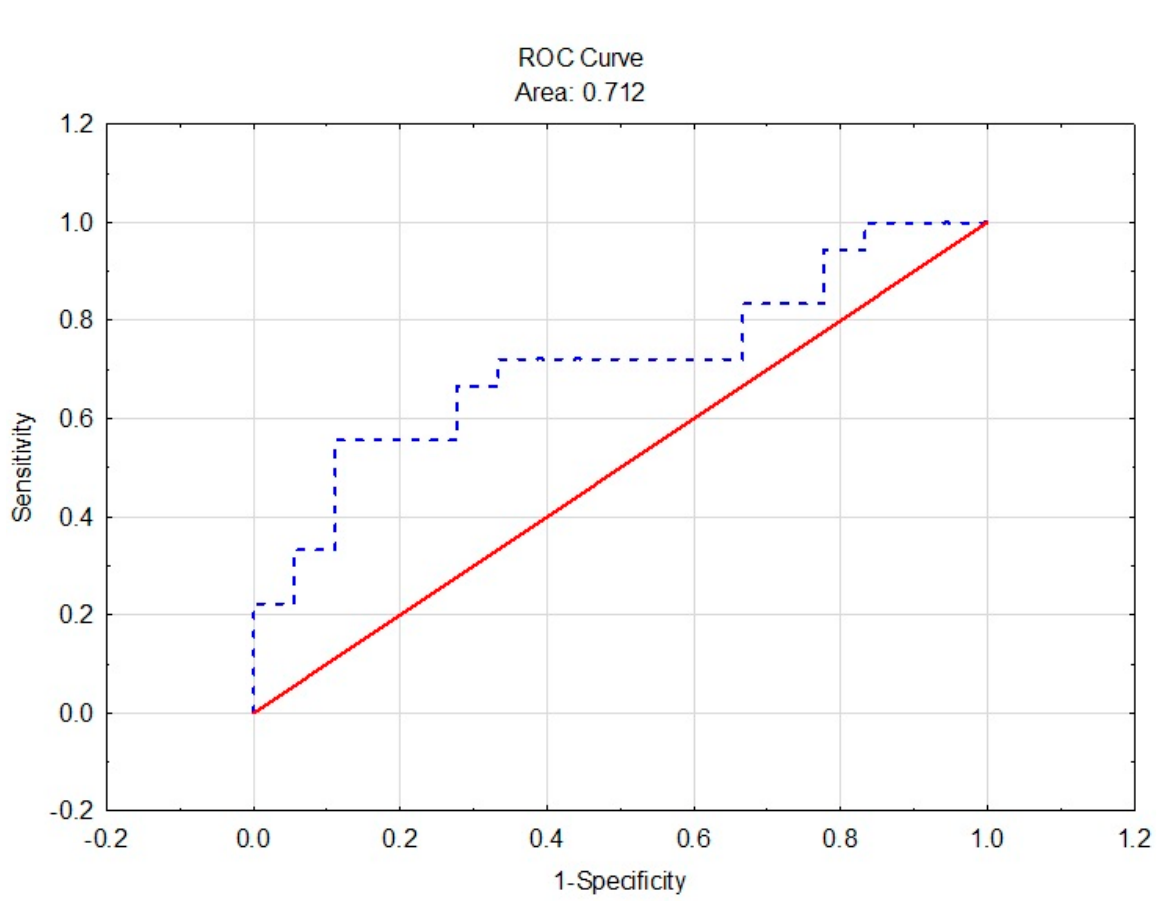
Figure 2. ROC curve of the bilateral extensor imbalance (% Ext). Table 6. Logistic regression model results with ipsilateral imbalances as a predictor.